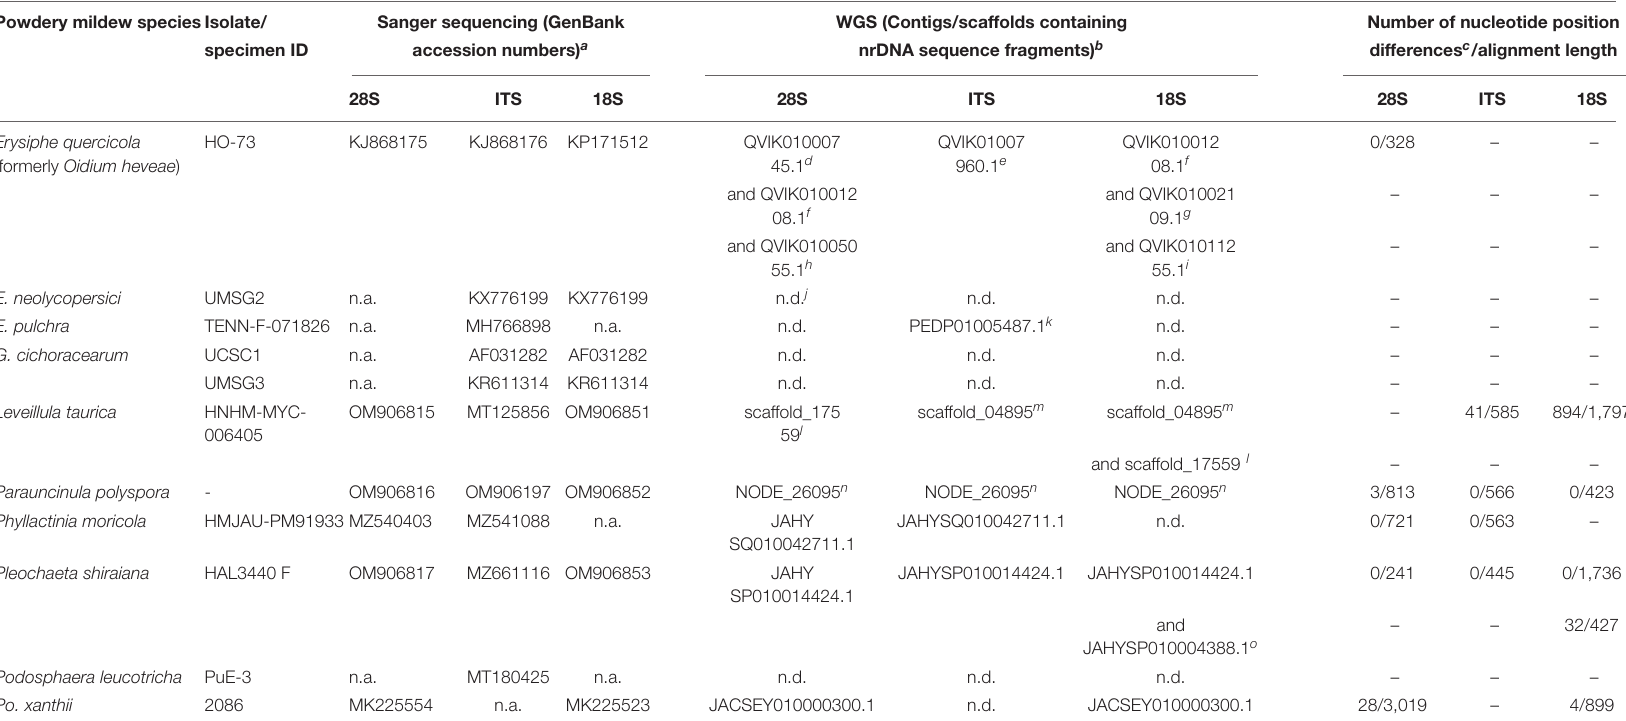
TABLE 5 | Comparison of 28S, ITS and 18S sequences extracted from whole genome sequencing (WGS) datasets (genome assembly accession numbers shown in Table 4) to sequences determined by Sanger sequencing available at NCBI GenBank database. Powdery mildew